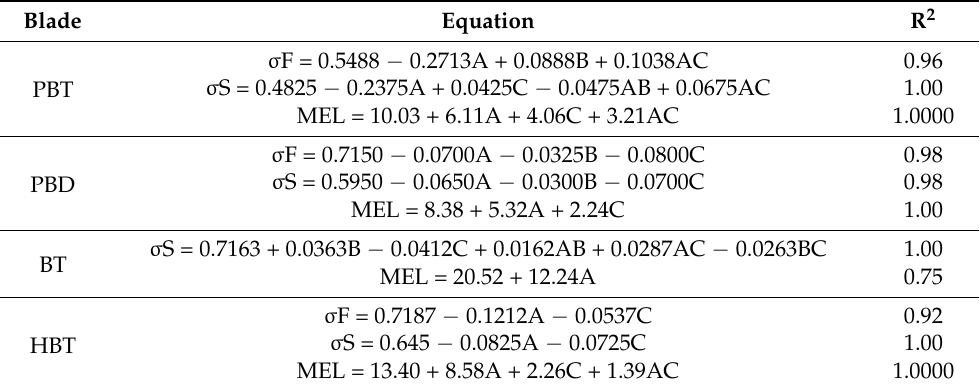
Table 3. The mathematical equation of significant factors affecting